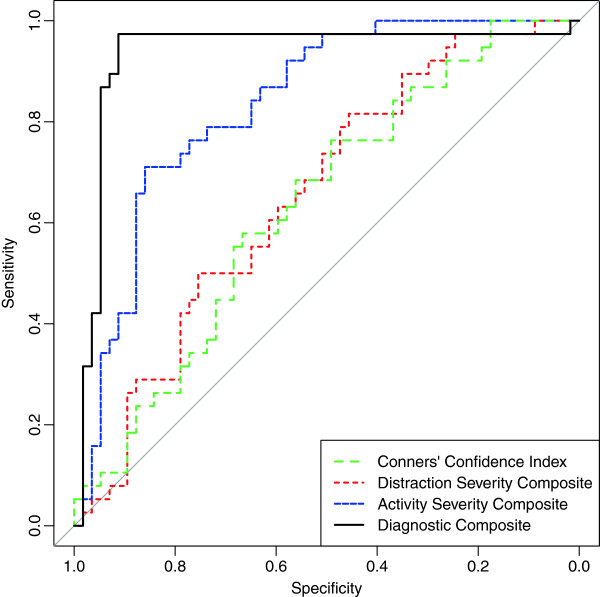
Receiver operating characteristic curves for age and gender covaried composite measures of attention and activity. Conners’ Confidence Index comes from the Conners CPT-II. Attention Severity, Activity Severity and Diagnostic Composites derived from the No-4’s cognitive control task and infrared motion analysis.